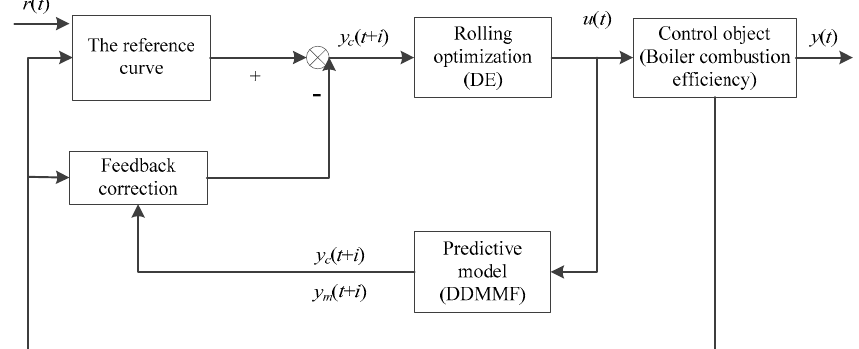
Figure 7. The proposed model predictive control structure.